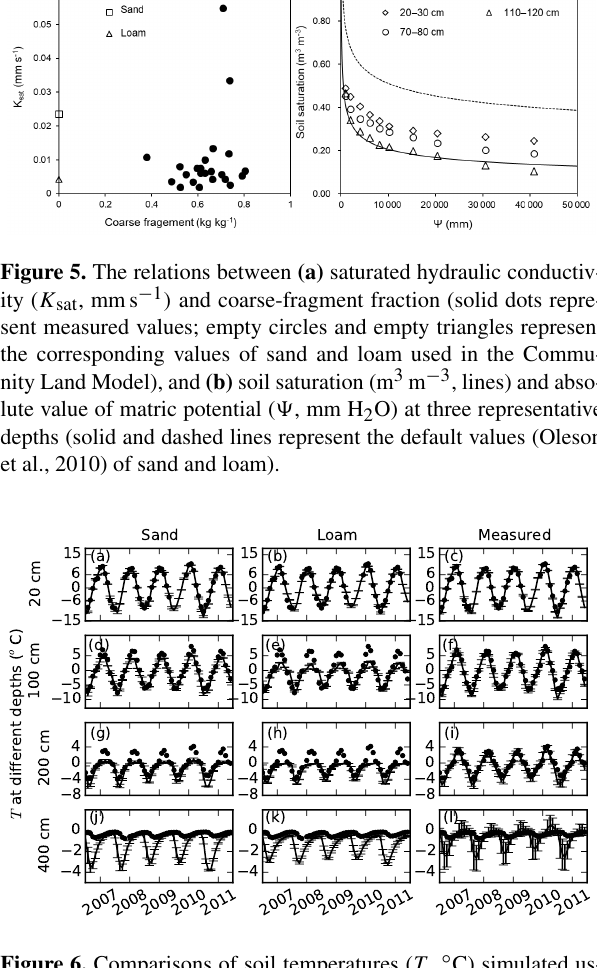
Figure 6. Comparisons of soil temperatures ( T , ◦ C) simulated us- ing default parameters for sand, loam, and our measured parameters (lines) with measured soil temperatures (dots) at 20, 100, 200, and 400cm depths. Error bars show the standard deviations calculated based on nine simulations with three different slopes and three dif- ferent soil thicknesses (measured porosities were used in the simu-